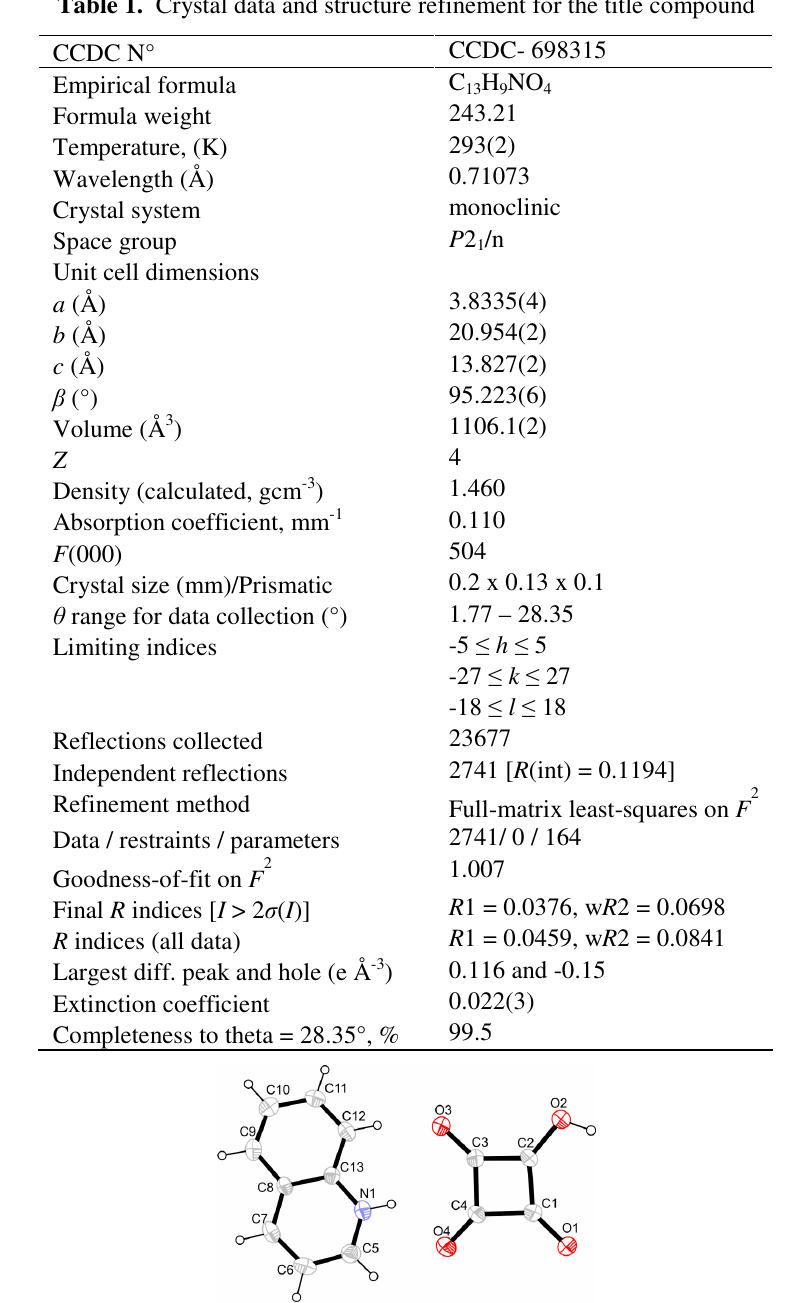
Table 1. Crystal data and structure refinement for the title compound